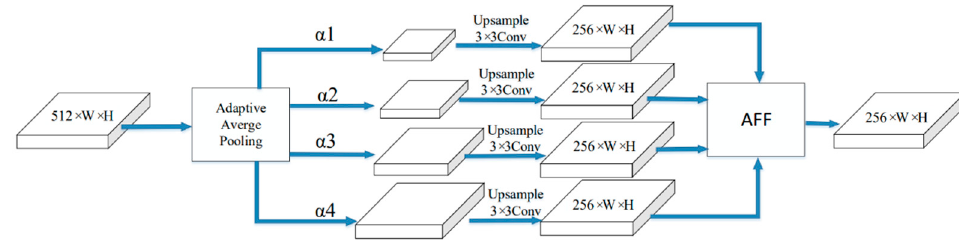
Figure 6. Schematic diagram of the network structure of the high-level feature enhancement (HLFE) module.